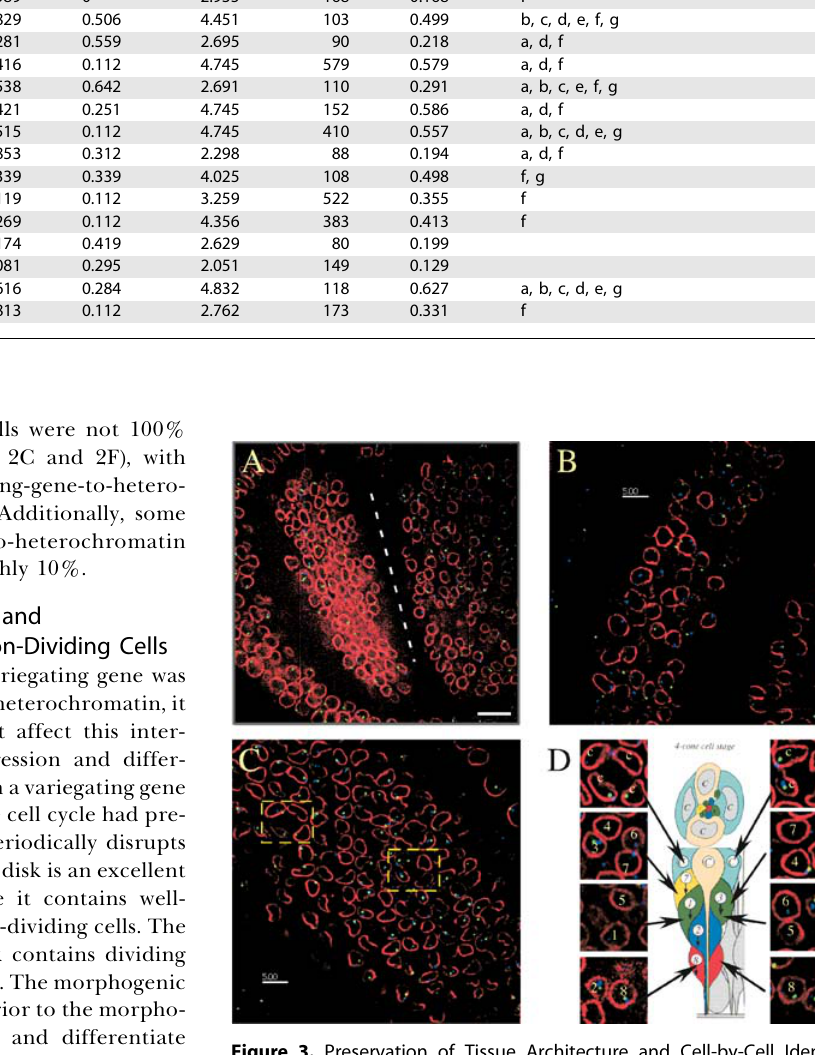
Figure 3. Preservation of Tissue Architecture and Cell-by-Cell Identi- fication in the Drosophila Eye Disk bw D eye disks were processed for FISH and stained for nuclear lamin as described in Materials and Methods. Red, fluorescein lamin stain; blue, AACAC-cy5 heterochromatic probe; green, rhodamine-labeled P1 probe covering brown . (A) Low-magnification view of eye disk showing anterior (left) and posterior (right) portions of the disk. Morphogenic furrow is marked with a dotted line. (B) View of cells anterior to morphogenic furrow. These cells are still dividing and have not yet undergone differentiation. (C) Cells posterior to morphogenic furrow. These cells have ceased dividing and are differentiating into adult eye structures. (D) Four cone cell clusters from the two boxes in (C), with each photoreceptor and cone cell identified. Apical cells are at the top, basal at the bottom. DOI: